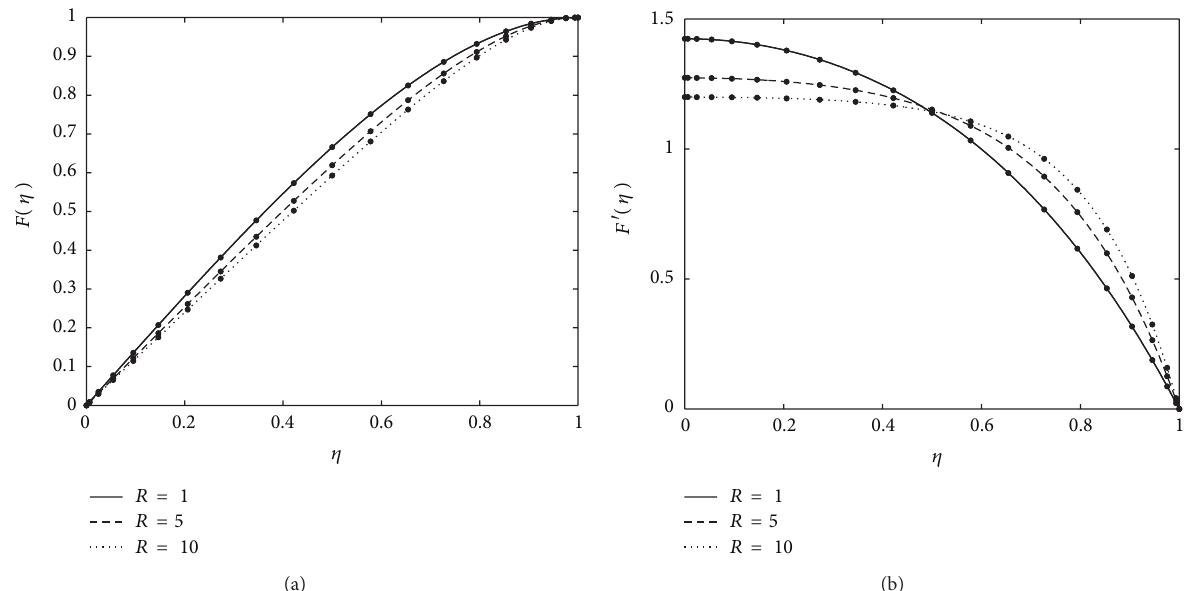
Figure 4: Comparison between the 10th order SLM approximate solution (circles) and the bvp4c numerical results for the normal velocity profile 𝐹(𝜂) and longitudinal velocity profile 𝐹 󸀠 (𝜂) for different values of 𝑅